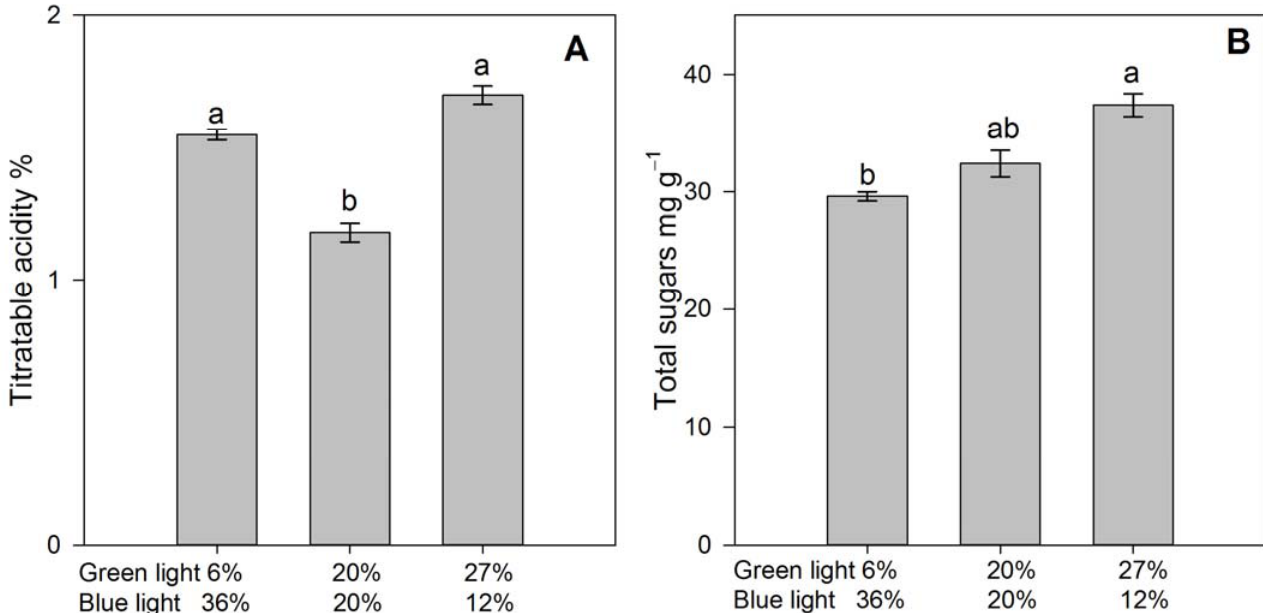
Figure 7. Effect of the green (500–600 nm) and blue (400–500 nm) light balance on titratable acidity ( A ) and total sugars ( B ) concentration in fruits from strawberry plants grown in an indoor vertical system with LED lighting. Bars represent the standard error of the mean. Columns with different letters indicate significant differences according to Duncan´s multiple comparison test with p < 0.05. Table 7. Effect of the green (500–600 nm) and blue (400–500 nm) light balance on selected ions con- centration and on flavonoids, anthocyanins and antioxidant activity measured by FRAPS from ex- tracts of strawberry fruits of plants grown in an indoor vertical system with LED lighting.